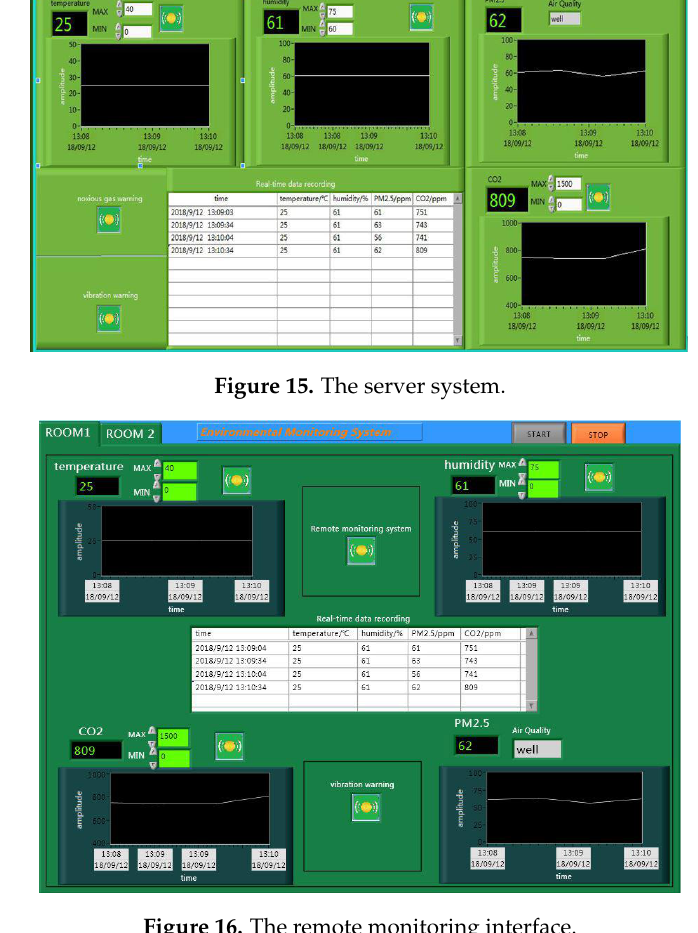
Figure 16. The remote monitoring interface.